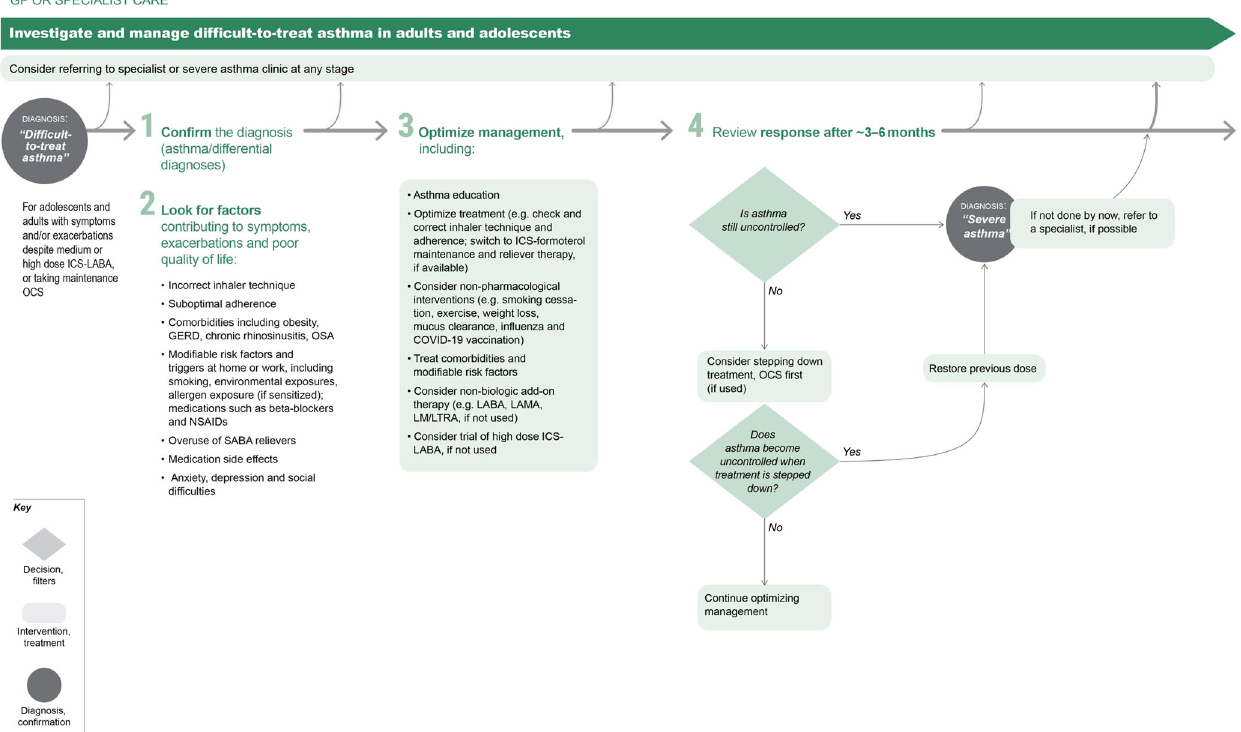
Fig. 7 Investigating and managing dif fi cult-to-treat asthma in adult and adolescent patients. ICS inhaled corticosteroid, LABA long-acting beta 2 agonist, LAMA long-acting muscarinic antagonist, LTRA leukotriene receptor antagonists, SABA short-acting beta 2 agoinst, OCS oral corticosteroid. The GINA strategy includes a decision tree about the management of dif fi cult-to-treat and severe asthma spanning primary through tertiary care. The section of the fl ow diagram applicable to generalists in primary and secondary care is shown here. Source: Box 3 – 16A in GINA report 2022. Reproduced with permission from ref. 11